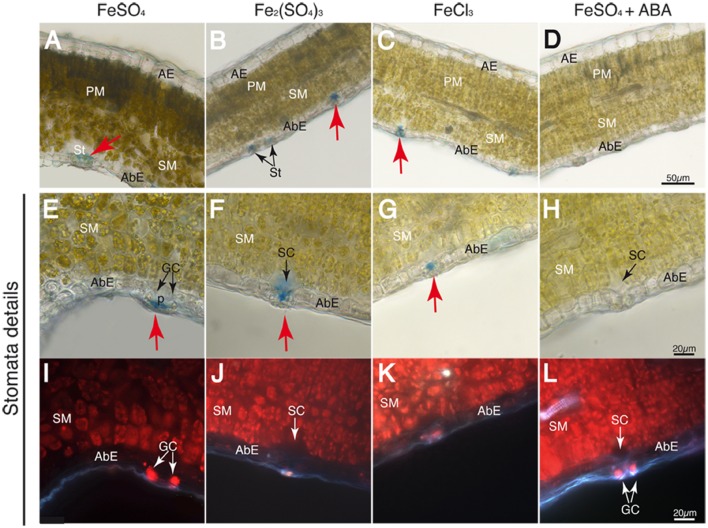
Localization of labile Fe pools using Perls blue staining in transversal leaf sections taken 30 min after Fe foliar fertilization: leaf blades (A–D), close-up of stomatal areas (E–H) and chlorophyll fluorescence image of the same fields in E–H, revealing the location of stomatal guard cells and mesophyll cells (I–L) Leaves were treated with FeSO4(A,E,I), Fe2(SO4)3(B,F,J), FeCl3(C,G,K), and FeSO4 in ABA-treated plants (D,H,L). Abaxial and adaxial epidermis (AbE and AE), parenchima and spongy mesophyll tissue (PM and SM), stomata (St) and stomatal guard cells (GC), cavities (SC), and pores (p) are marked in the images. The scale bars correspond to 50 and 20 μm in (A–D) and (E–L), respectively.